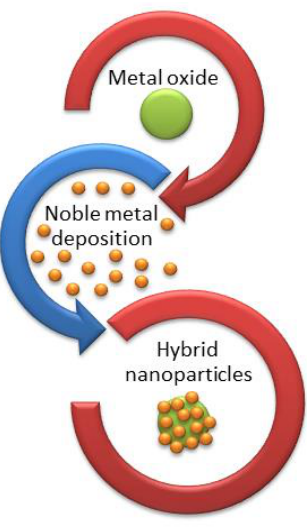
Figure 3. Schematic representation of chemical reduction (CR) method for the production of OM/noble metal hybrid nanoparticles.